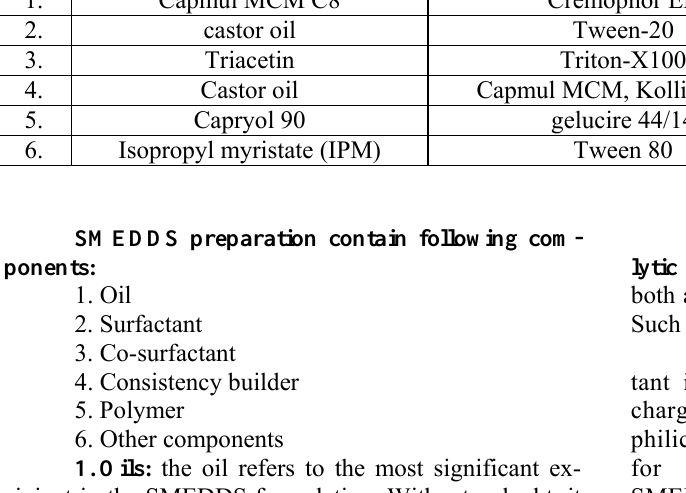
Classification of excipients used in formulation of SMEDDS on the basis of various literatures survey